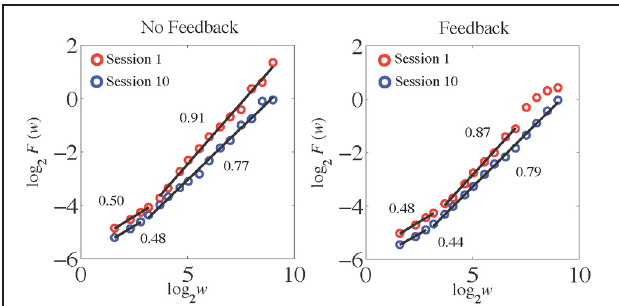
FIGURE 7 | AFA plots for the time series of time estimates presented in Figure 6. The H fGn values are indicated for each scaling region.